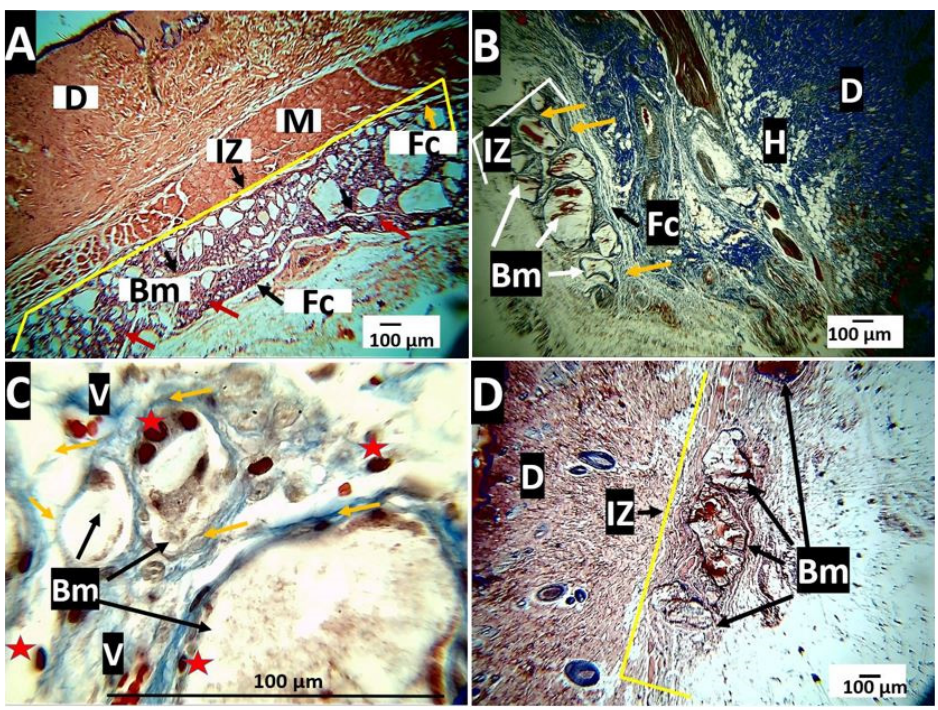
Figure 15. Nanocomposites of PLA/n-BGs 10 wt.% implanted at 30, 60, and 90 days. ( A ): 30 days, Hematoxylin-Eosin technique, 4 × . ( B ): 60 days, Masson’s Trichrome technique, 4 × . ( C ): 60 days, Masson’s Trichrome technique, 100 × . ( D ): 90 days, hematoxylin-eosin technique, 4 × . D: dermis. H: hypodermis. M: muscle. IZ: implantation zone. Fc: fibrous capsule. Bm: biomaterial. Yellow arrows: collagen I fiber. V: blood vessel. Red arrows: inflammatory cells. Red star: inflammatory cells.